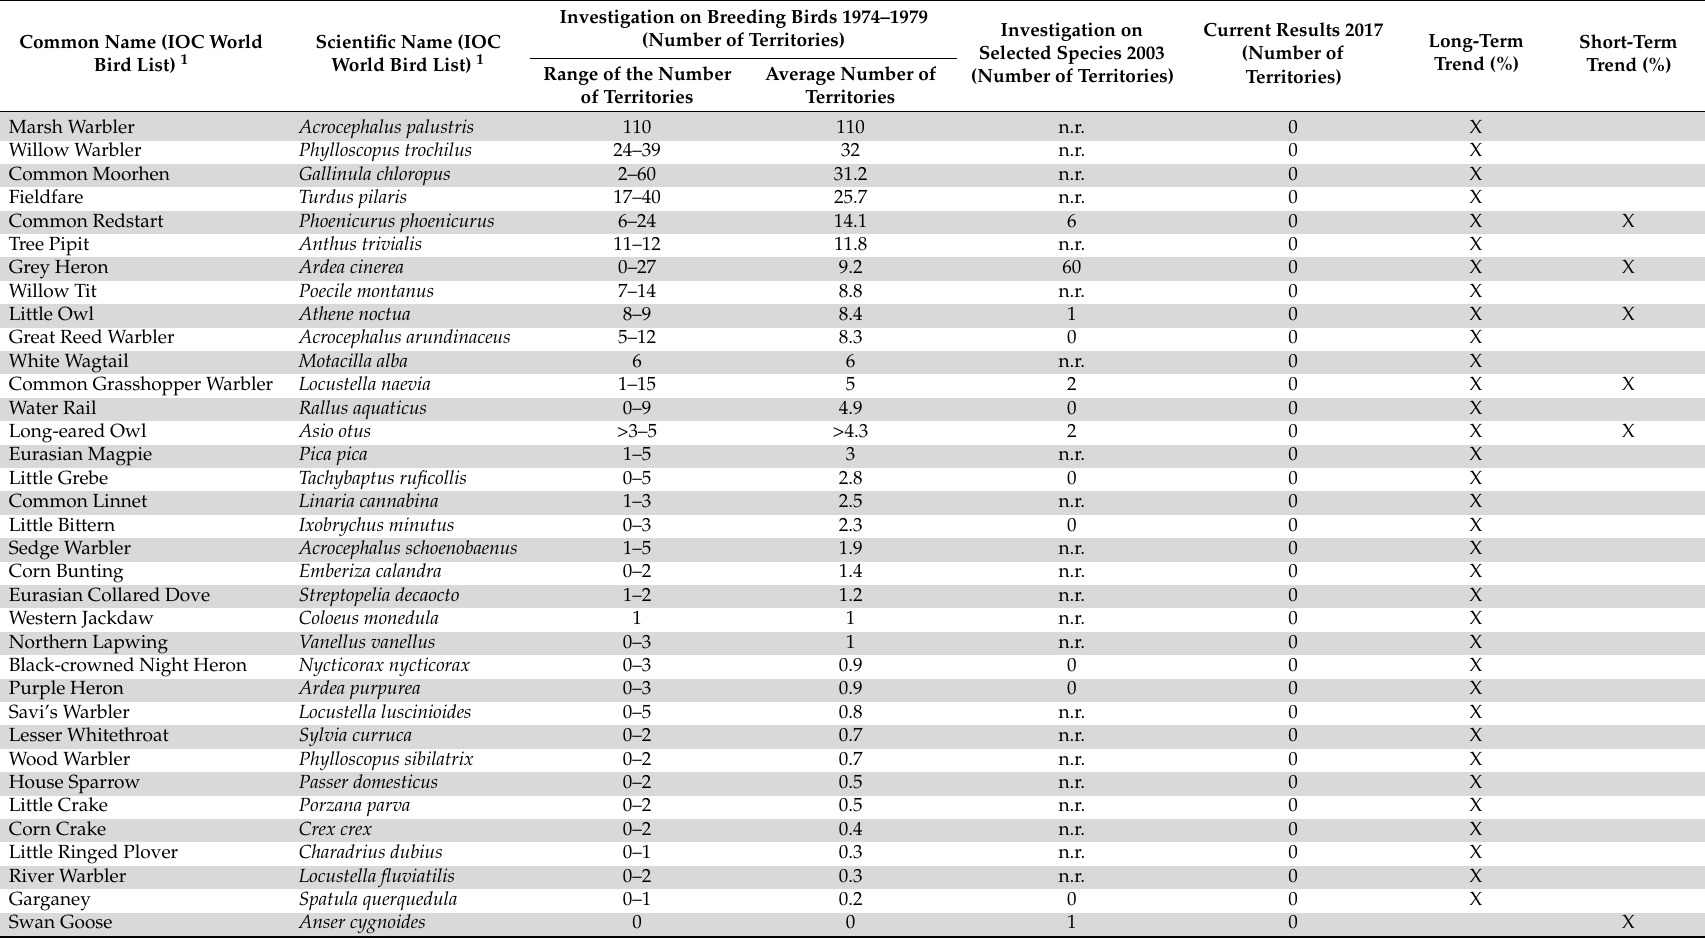
Table 2. Comparison of the number of territories in 2017 with results of former investigations on breeding birds from 1974 to 1979 and in 2003 at “Lampertheimer Altrhein”. The long-term trend is based on the average number of territories between 1974 and 1979 [14]. The short-term trend is based on the number of territories in 2003 [15]. Species are sorted from negative to positive population developments in the long-term